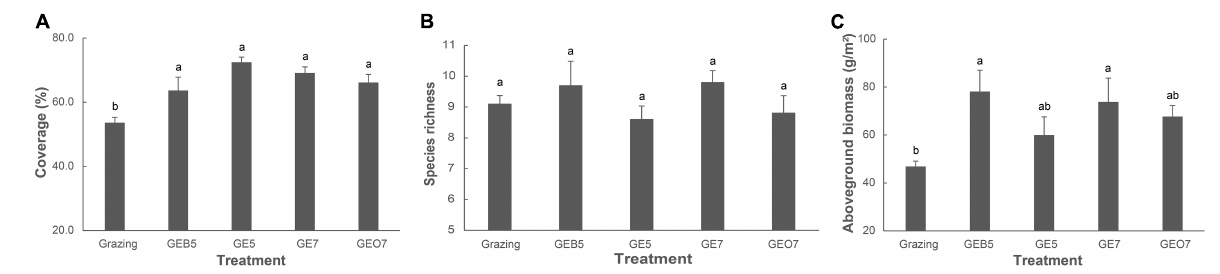
FIGURE 2 | Changes of the coverage (A) , species richness (B) , and aboveground biomass (C) of plant communities along a grazing exclusion gradient in the central QTP. Different letters indicate significant variation at the level of α = 0.05.